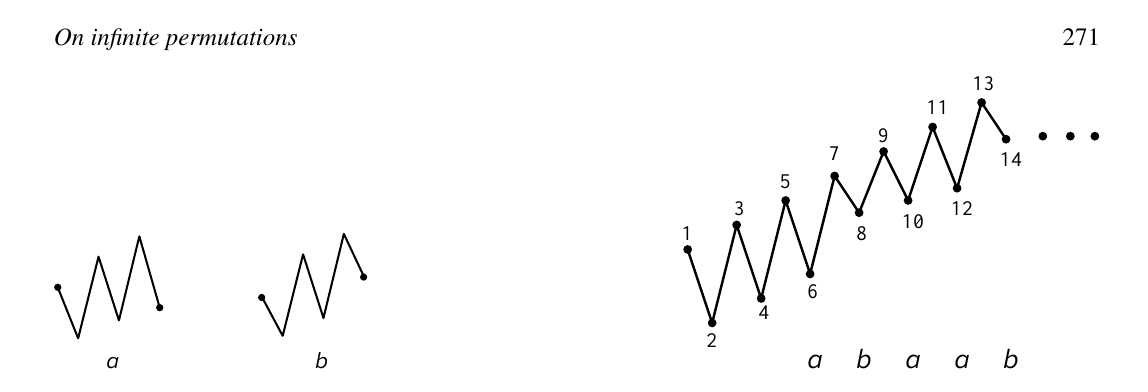
Fig. 2: A Z -permutation of complexity at least n − 3 based on the Fibonacci